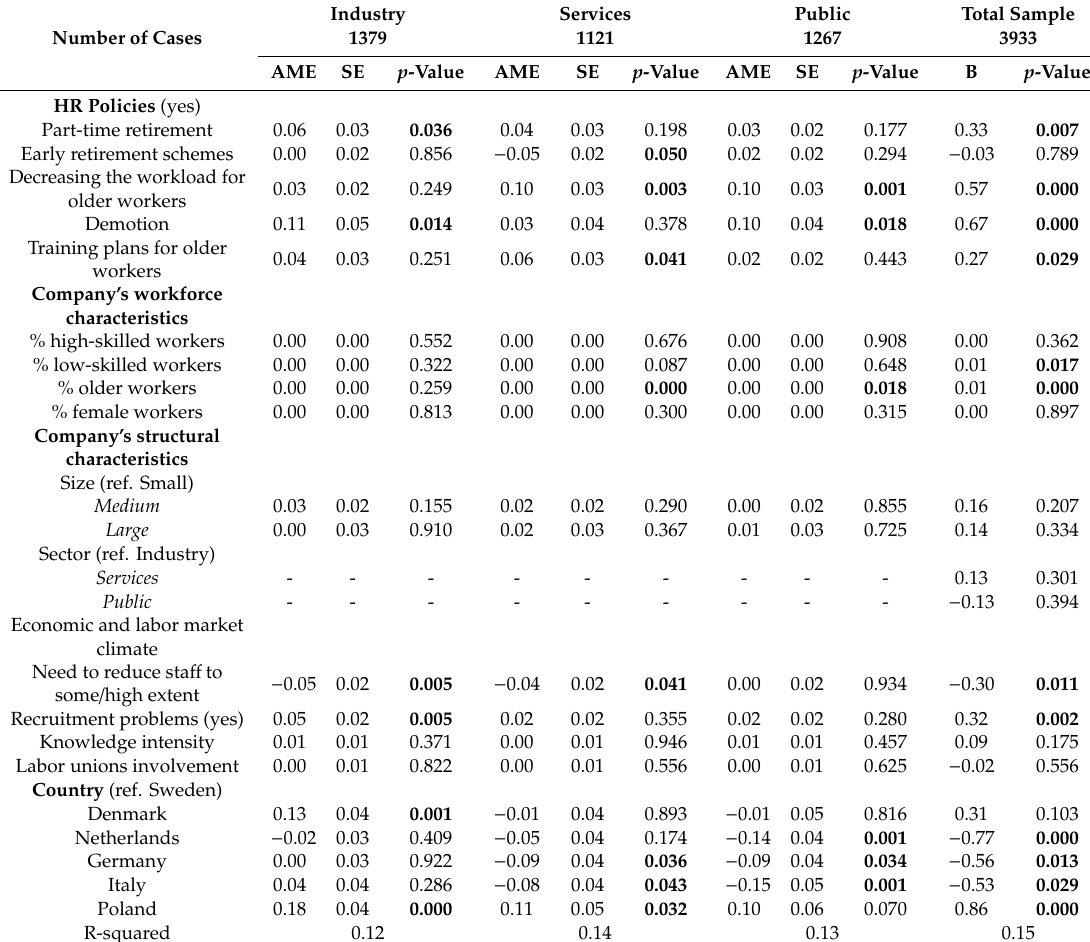
Table 3. Explanatory variables for the encouraging working beyond retirement age, by sector and total